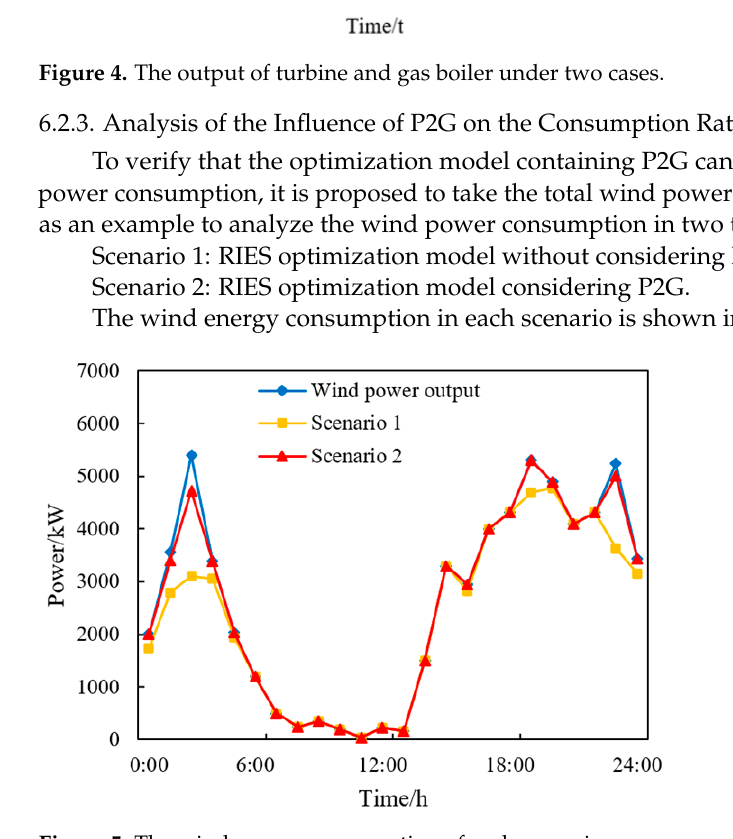
Figure 5. The wind energy consumption of each scenario.